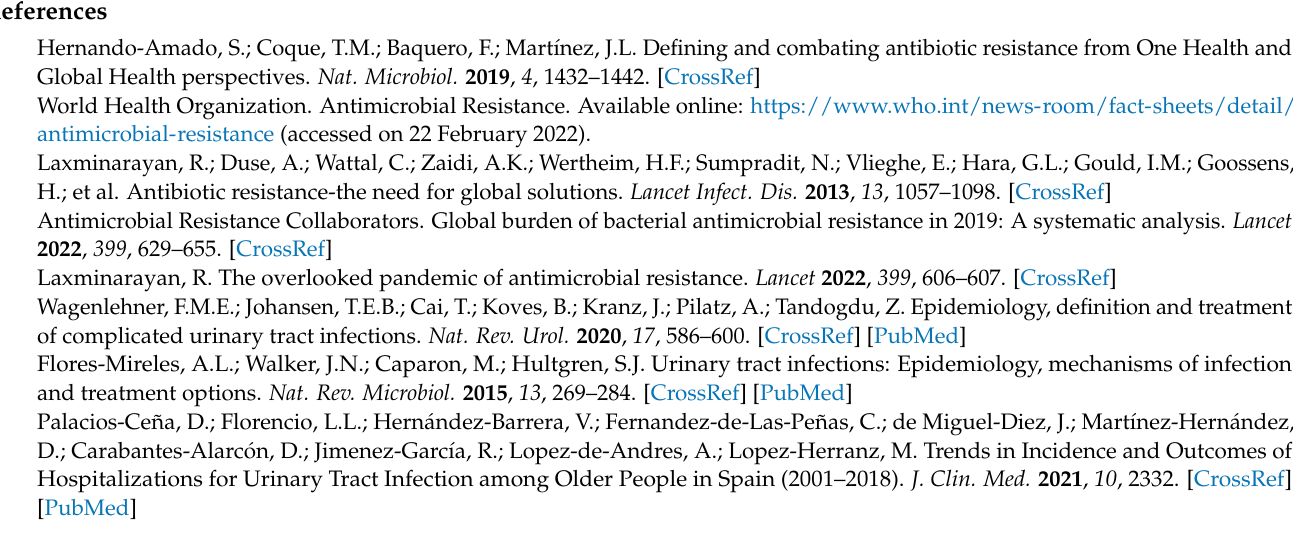
region. Table S2: All-age count of deaths attributable to bacterial AMR among 13 antibiotic classes and 14 pathogens for 21 GBD regions. Figure S1: All-age rate of DALYs attributable to and associated with bacterial AMR among 21 GBD regions, 2019. Figure S2: All-age count of DALYs attributable to and associated with bacterial AMR globally among 14 pathogens, 2019. Figure S3: Fraction of DALYs attributable to (A) and associated with (B) bacterial AMR among 21 GBD regions and 14 pathogens, 2019. Figure S4: All-age count of DALYs attributable to and associated with bacterial AMR globally among 13 antibiotic classes, 2019. Figure S5: Fraction of DALYs attributable to (A) and associated with (B) bacterial AMR among 21 GBD regions and 13 antibiotic classes,